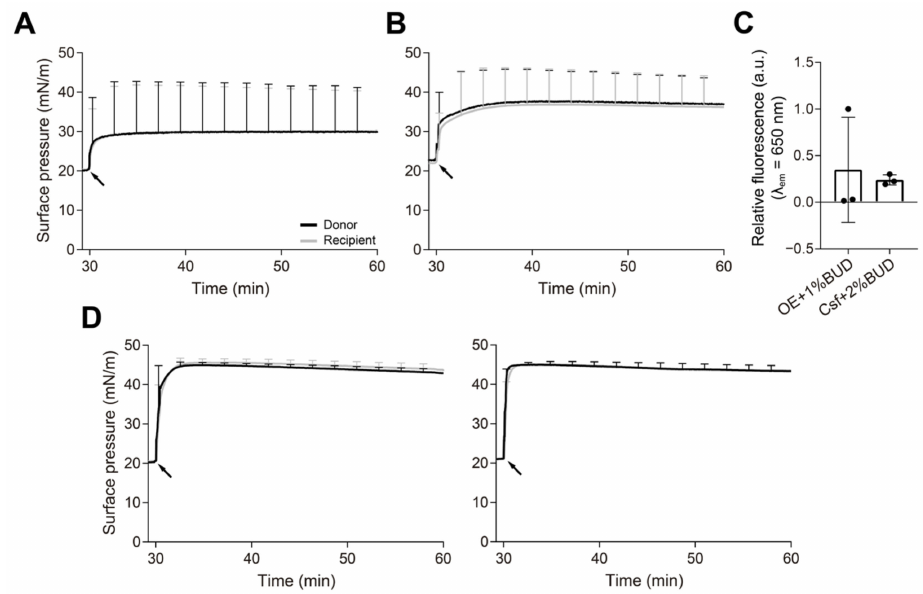
Figure 6. Interfacial spreading of PS over surfactant-occupied interfaces. Π -time isotherms of aqueous suspensions of ( A ) OE + 1% ( w / w ) BUD and ( B ) Curosurf + 2% ( w / w ) BUD, injected at time 30